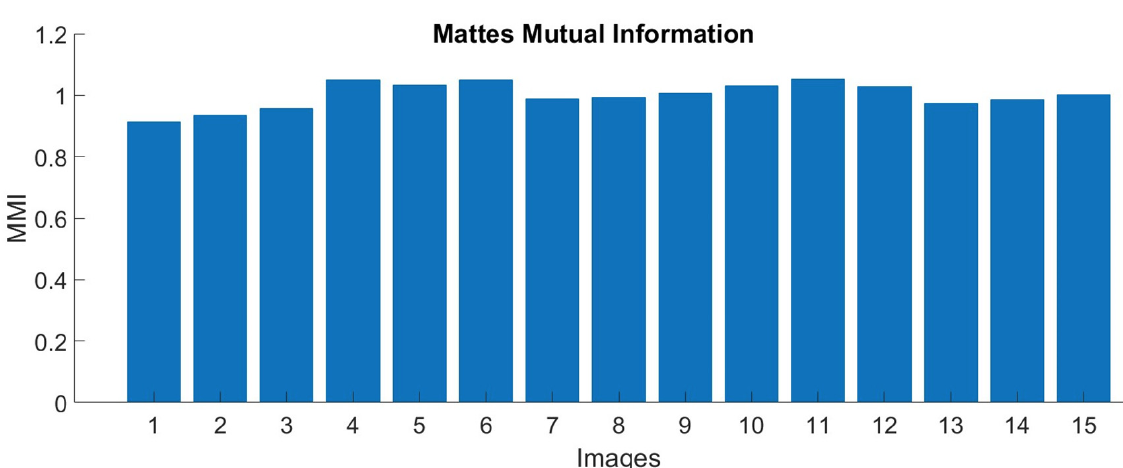
Figure 14. Mattes mutual information between multispectral and thermal images after registration.